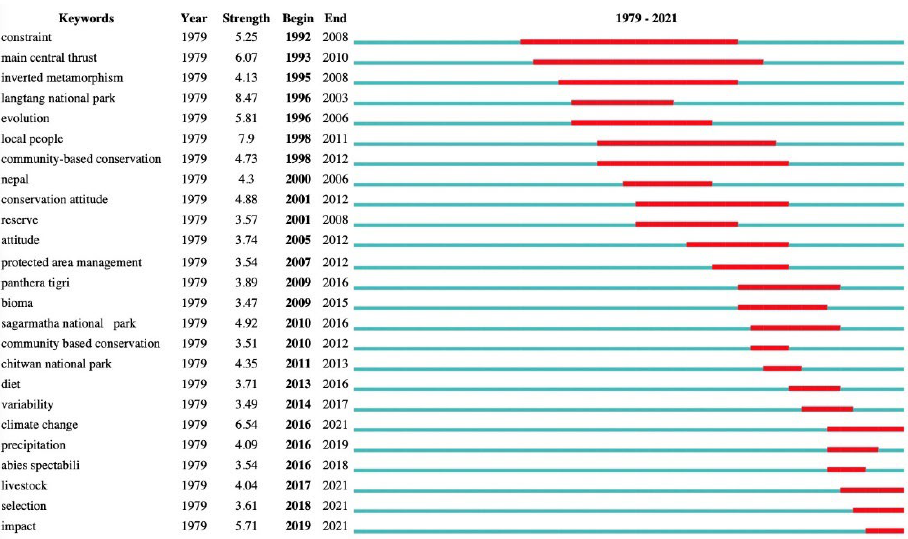
Figure 8. Citation burst detection.